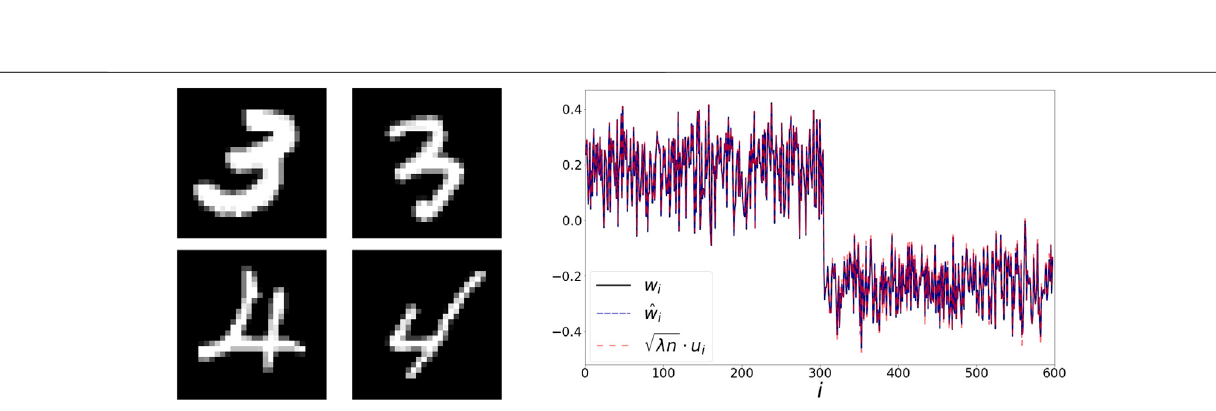
FIGURE3 |Left: handwritten digits from the MNIST dataset. Right: Theextractedrepresentations w , (cid:13) w and we present a scatter plot comparing the values of (cid:13) w and